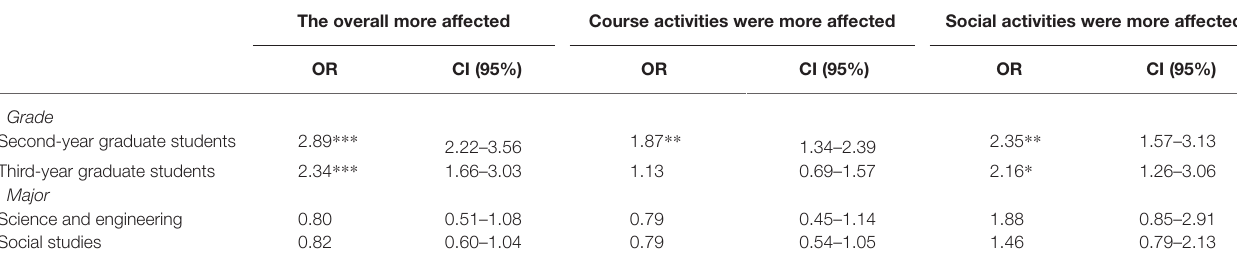
TABLE 4 | Multinomial logistic regression of demographic variables on each latent class.